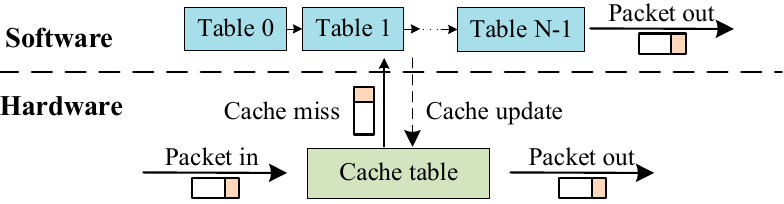
Figure 3. Matching process. The OpenFlow pipeline is stored in the software and the cache is stored in the Ternary Content Addressable Memory